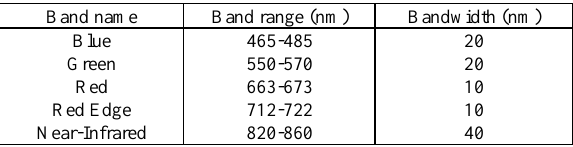
Spectral characteristics of the MicaSense RedEdge narrowband camera (MicaSense Inc., 2017).